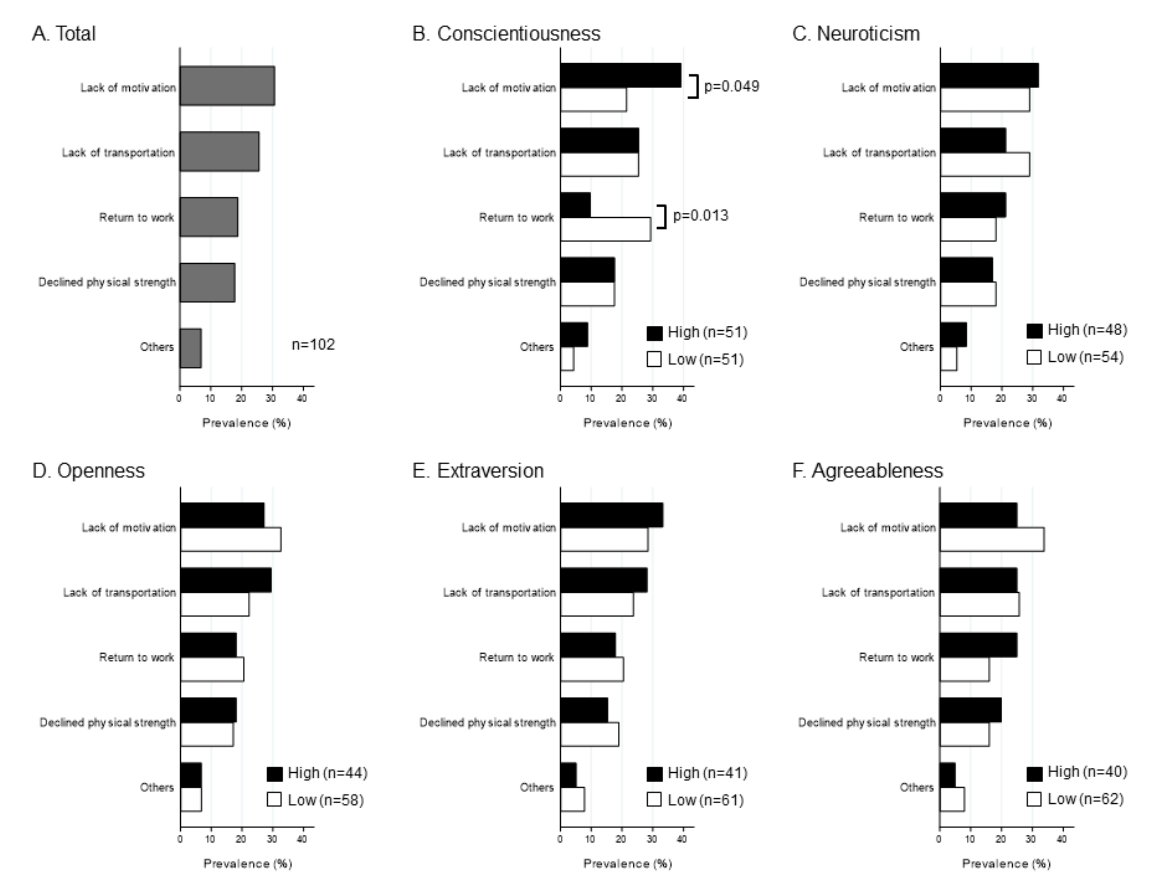
Figure 4. Reasons for non-participation in outpatient CR according to the median level of each personality trait ( n = 102). * p < 0.05 for chi-square test (high level vs. low level). CR, cardiac rehabilitation.